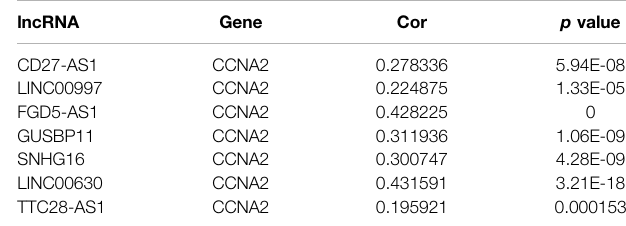
TABLE 4 | lncRNAs are positively correlated with CCNA2 in